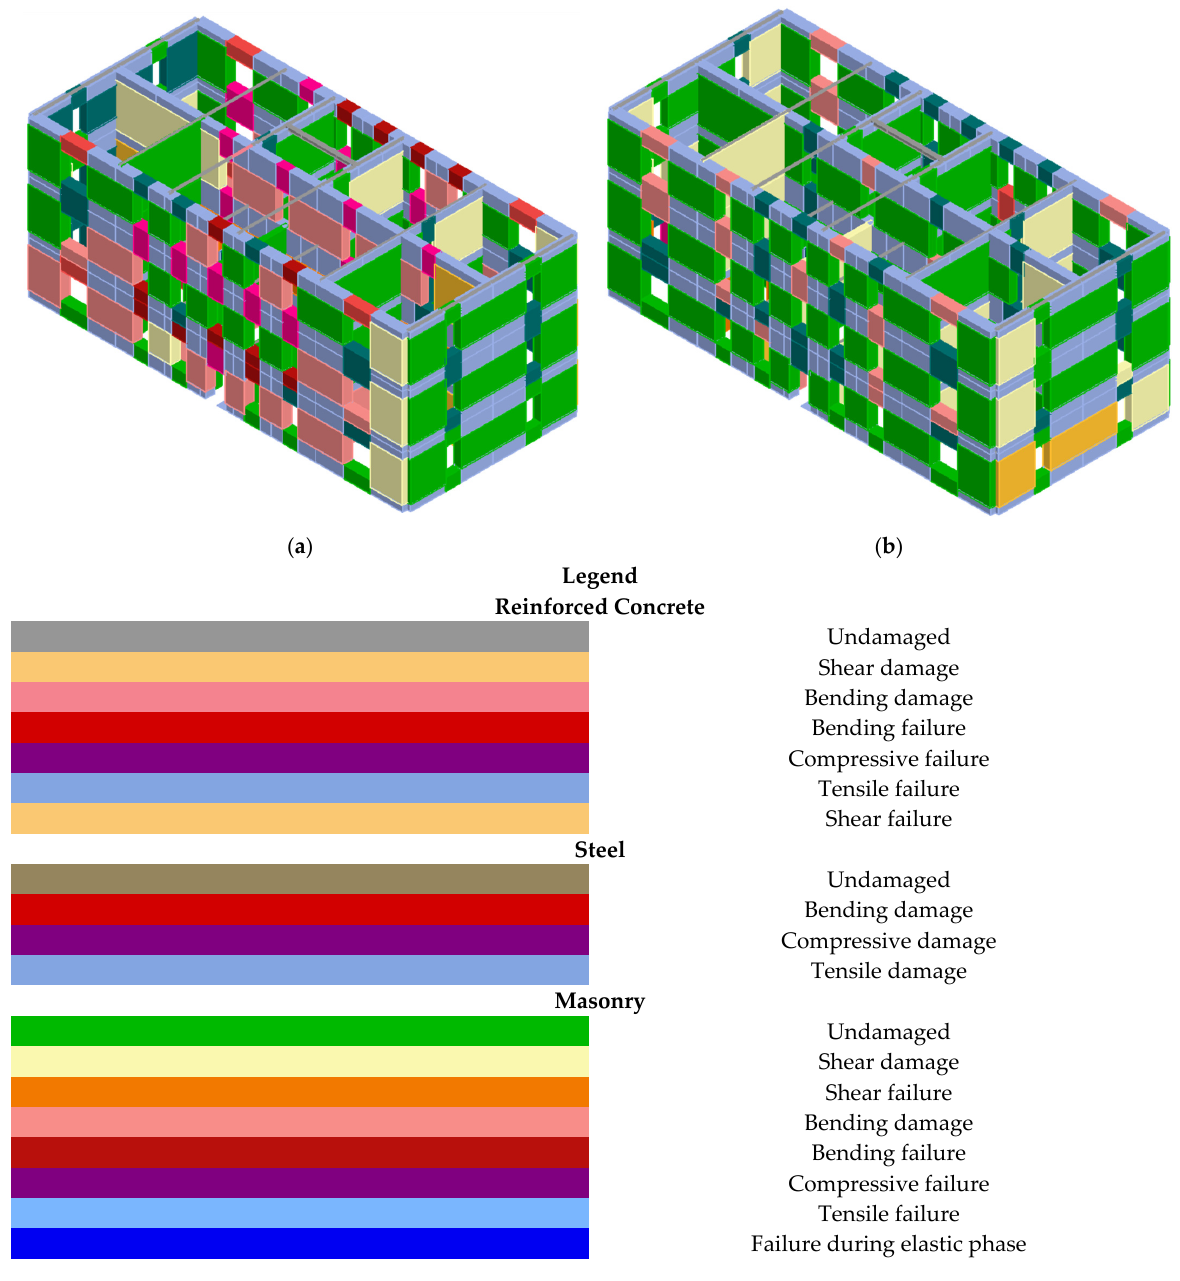
Figure 18. Three-dimensional (3D) model with damage for the near-collapse limit state: ( a ) x -direction; ( b ) y -direction. Table 5. Capacity/demand ratios obtained by different methods of analysis.